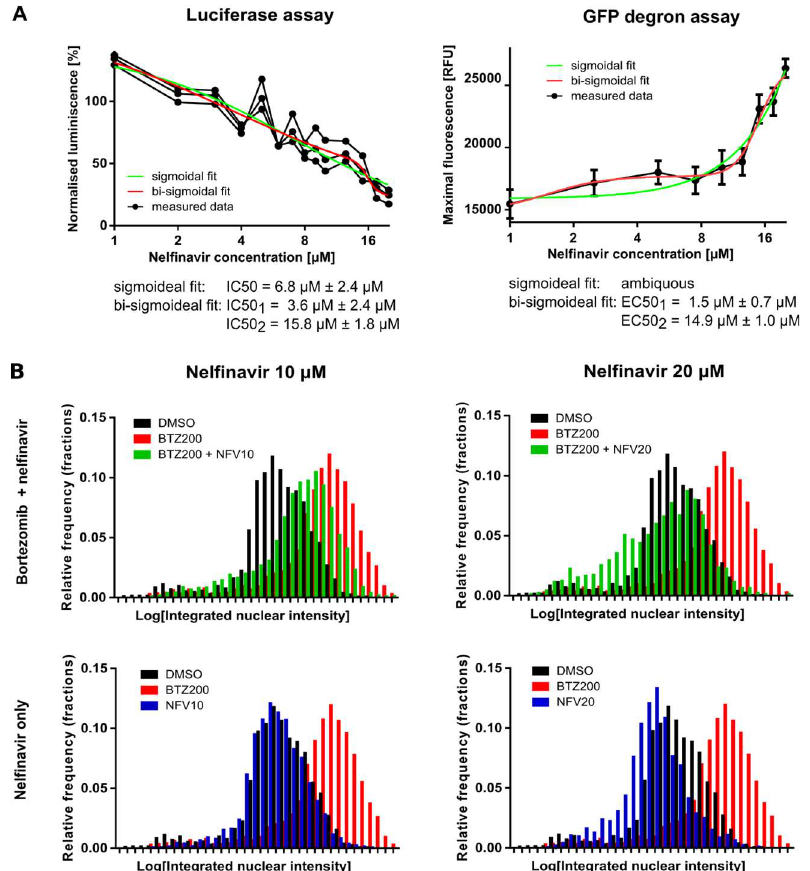
Figure 2. Nelfinavir inhibits Nrf1 transcriptional activity by a dual mode of action. ( A ) Left: HEK293 cells stably expressing 3×PSMA4-ARE-Luc reporter were transfected with renilla luciferase gene for normalization and co-treated with 1 μM MG132 and nelfinavir concentrations spanning 1 μM to 20 μM. At 16 h post-transfection, dual luciferase assays were used to measure firefly and renilla luciferase activity. Normalized luciferase activity is shown. The data were fitted by sigmoidal and bi-sigmoidal functions, and IC 50 values were calculated. Right: U2OS cells stably expressing Ub G76V -GFP reporter were treated with nelfinavir at concentrations spanning 1 μM to 20 μM. The GFP fluorescence (dependent on proteasome activity) was measured at different time points (0–24 h), and maxima were measured. The data were fitted by sigmoidal and bi-sigmoidal functions, and EC 50 values were calculated for the bi-sigmoidal fit. ( B ) HEK293 cells were co-treated with 200 nM BTZ and 10 μM or 20 μM NFV or DMSO for 16 h. TCF11/Nrf1 was detected using monoclonal antibody D5B10 (Cell Signaling, #8052; 1:50). The amount of nuclear TCF11/Nrf1 was estimated as integrated fluorescent nuclear intensity obtained by CellProfiler processing [29].